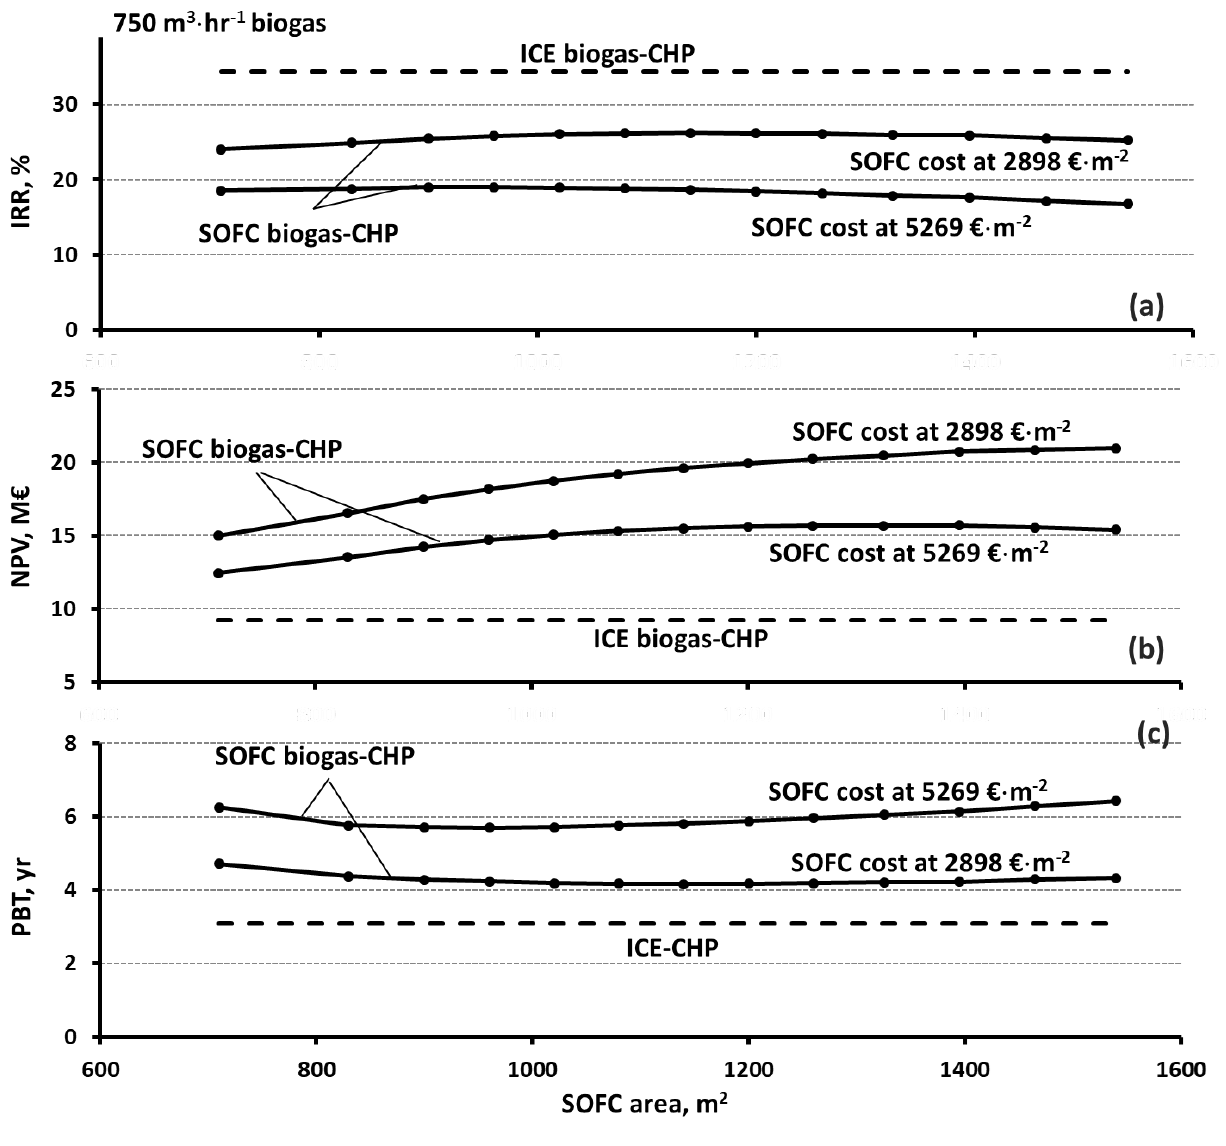
Figure 8. Dependence of: ( a ) IRR, ( b ) NPV and ( c ) PBT, of the smaller scale biogas plant (750 m 3 ·h −1 biogas), on the size of the employed SOFC unit and its area specific cost, and their comparison to conventional biogas-CHP of the same biogas capacity.